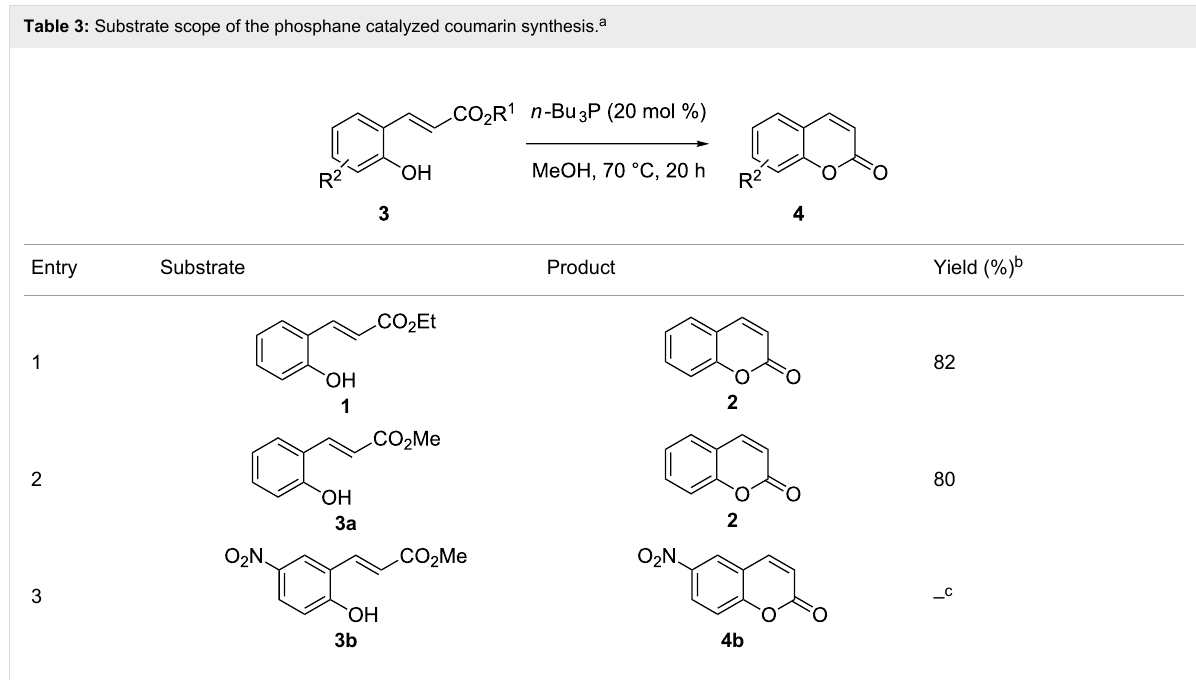
Table 3: Substrate scope of the phosphane catalyzed coumarin synthesis. a